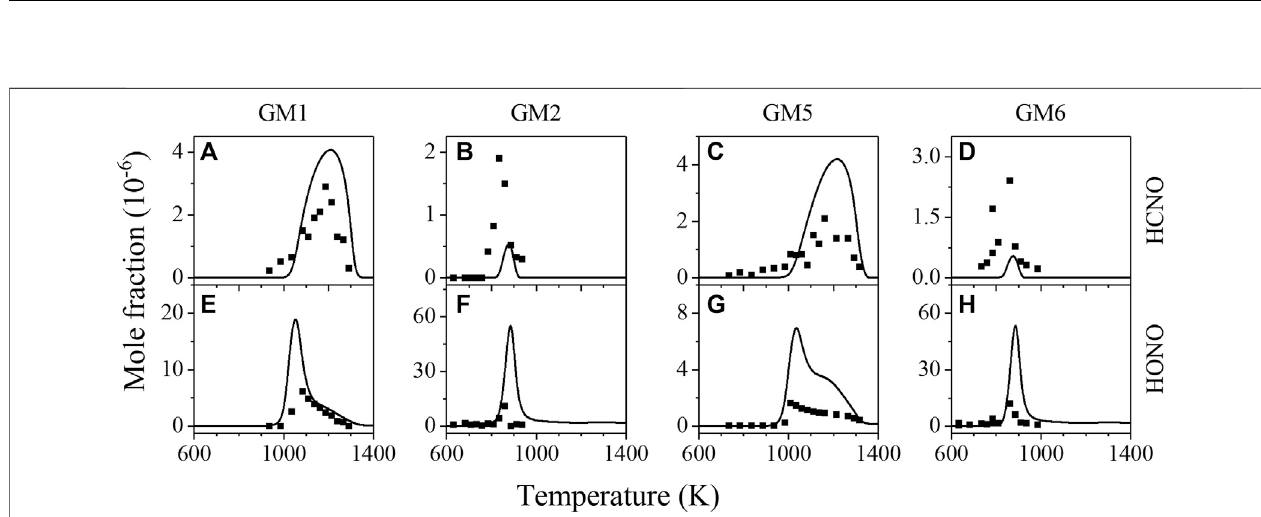
FIGURE 10 | Experimental (symbols) and simulated (lines) mole fraction pro fi les of HCNO and nitrous acid (HONO) in the oxidation of GM1, GM2, GM5 and GM6.